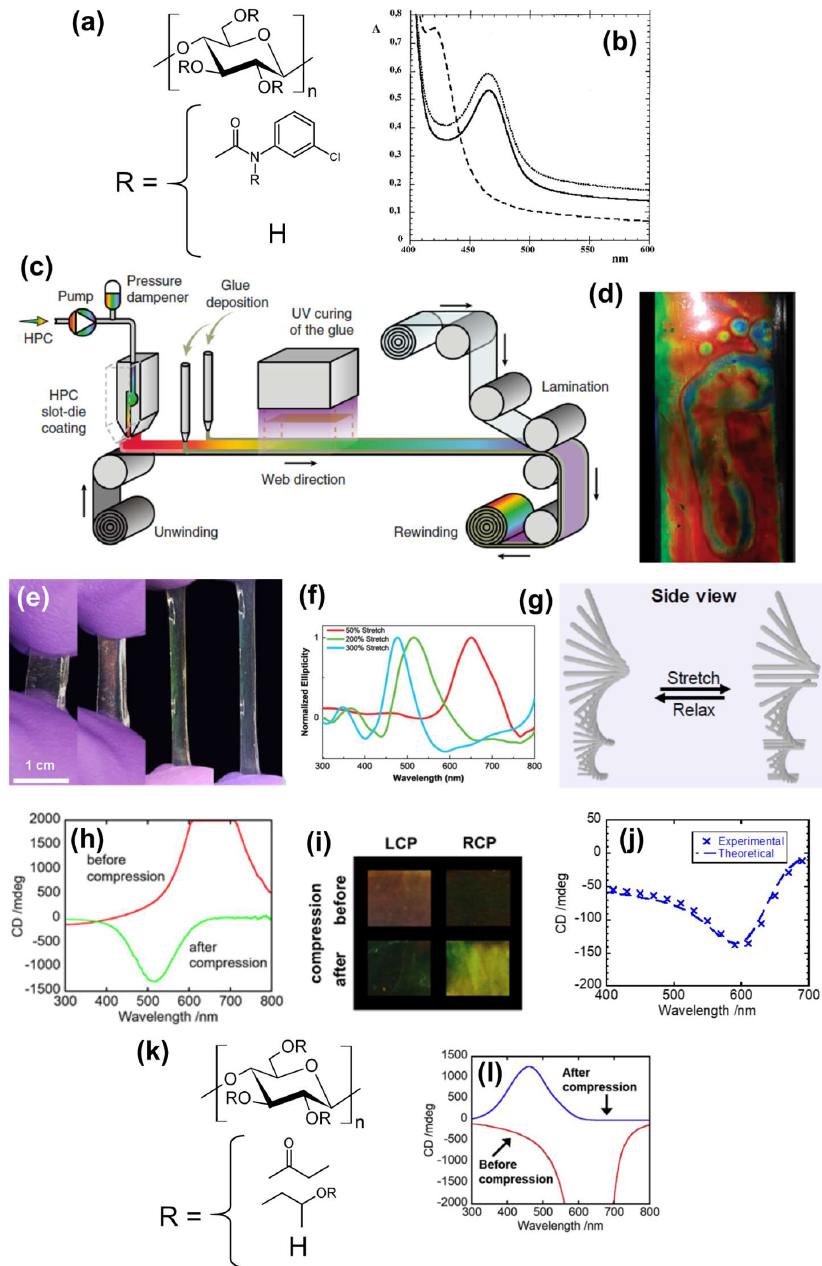
Figure 2. ( a ) Chemical structure of cellulose 3-chlorophenylcarbamate and ( b ) ultraviolet (UV)–visible spectra of a cholesteric liquid crystalline (ChLC) film before compression (solid line), directly after compression (dashed line), and after heating at 50 ◦ C (dotted line) (reproduced from [51] by permission of Wiley). ( c ) Schematic of roll-to-roll preparation of hydroxypropyl cellulose (HPC) ChLC films and ( d ) footprint exhibited by the films (adapted from [52] by permission of Springer Nature). ( e ) Visual appearances and ( f ) circular dichroism (CD) spectra of a stretched cellulose nanocrystal ChLC elastomeric film. ( g ) Proposed model of a change in the ChLC structure in the film under tensile (( e – g ) were reproduced from [53] by permission of Wiley). ( h ) CD spectra of ethylcellulose/poly(acrylic acid) (EC/PAA) ChLC films before and after compression at 130 ◦ C and ( i ) visual appearance through circular polarizers (LCP: left-handed circular polarizer; RCP: right-handed circular polarizer) (reproduced from [54] by permission of the Royal Society of Chemistry). ( j ) Experimental and theoretical CD spectra of compressed EC/PAA films (adapted with permission from [56], copyright (2021) American Chemical Society). ( k ) Chemical structure of propionylated HPC (PHPC) and ( l ) CD spectra of PHPC/poly(methyl methacrylate) ChLC films before and after compression at 30 ◦ C (reproduced from [58] by permission of